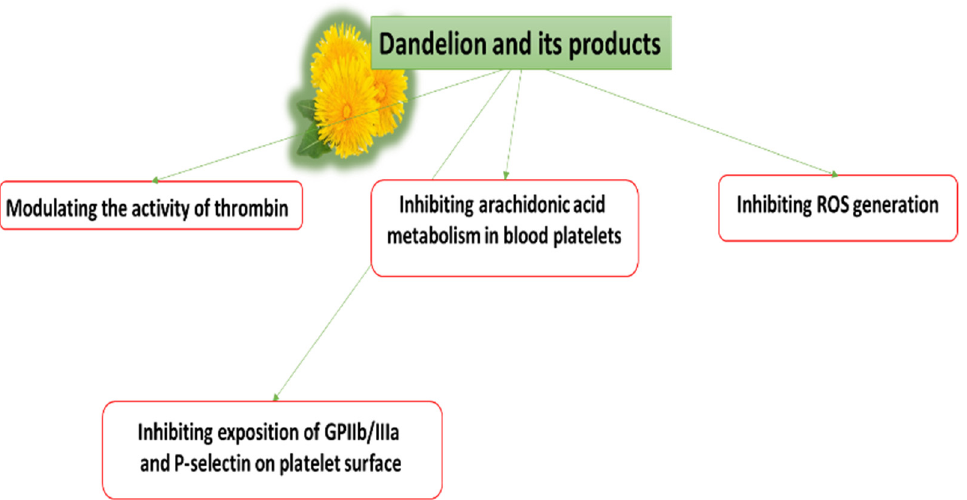
Figure 2. Proposed mechanisms of action of dandelion and its products on hemostasis.